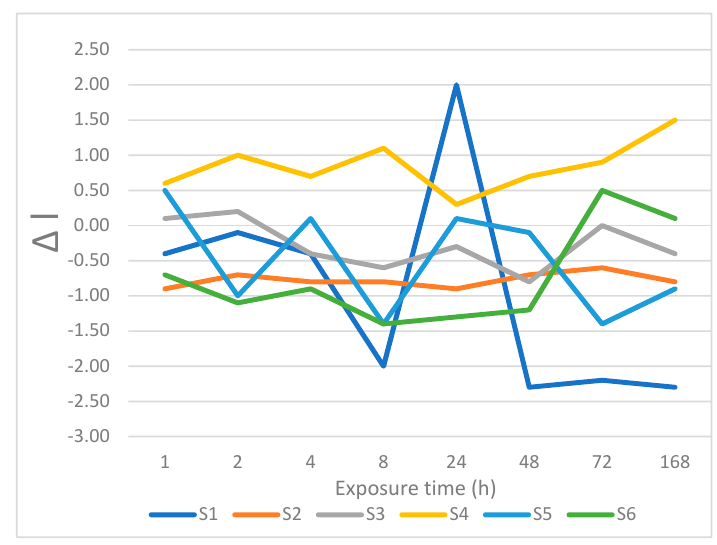
Figure 9. Changes is lightness after immersion in soy sauce.